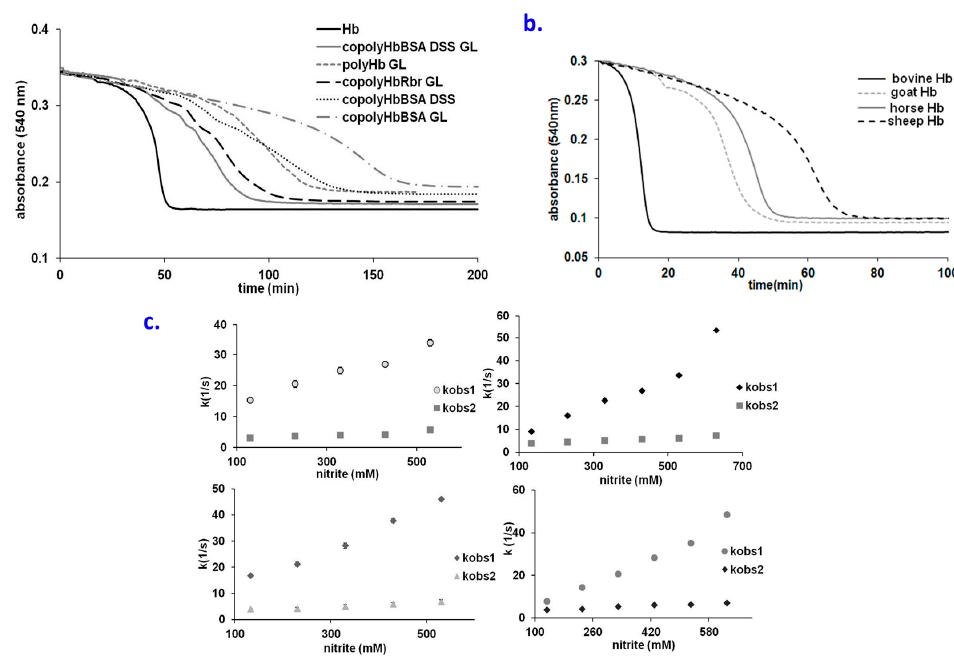
Figure 5. ( a ) Time course for the reaction of native or derivatized Hb (Hb + GL, Hb + BSA + GL, Hb + BSA + DSS, Hb + BSA + DSS + GL, Hb + Rbr + GL cf. Materials and Methods) with nitrite. Conditions: 25µM protein, 200µM nitrite, PBS 7.4, room temperature; ( b ) Time course for the reaction of Hb from different sources (cow, goat, horse, sheep) with nitrite. Conditions: 30 µM protein, 250 µM nitrite, PBS 7.4, room temperature; ( c ) Plots of k 1 and k 2 vs. NO 2 − concentration for the reaction of different derivatized oxiHb with NO 2 − at pH 7.4, aerobic; Left panel: up-polyHb, down- copolyHbBSA GL, right: up-copolyHbRbr, down-copolyHbBSA DSS. See also Supplementary Information Tables S1, S3 and S6 and Figures S17–S24.